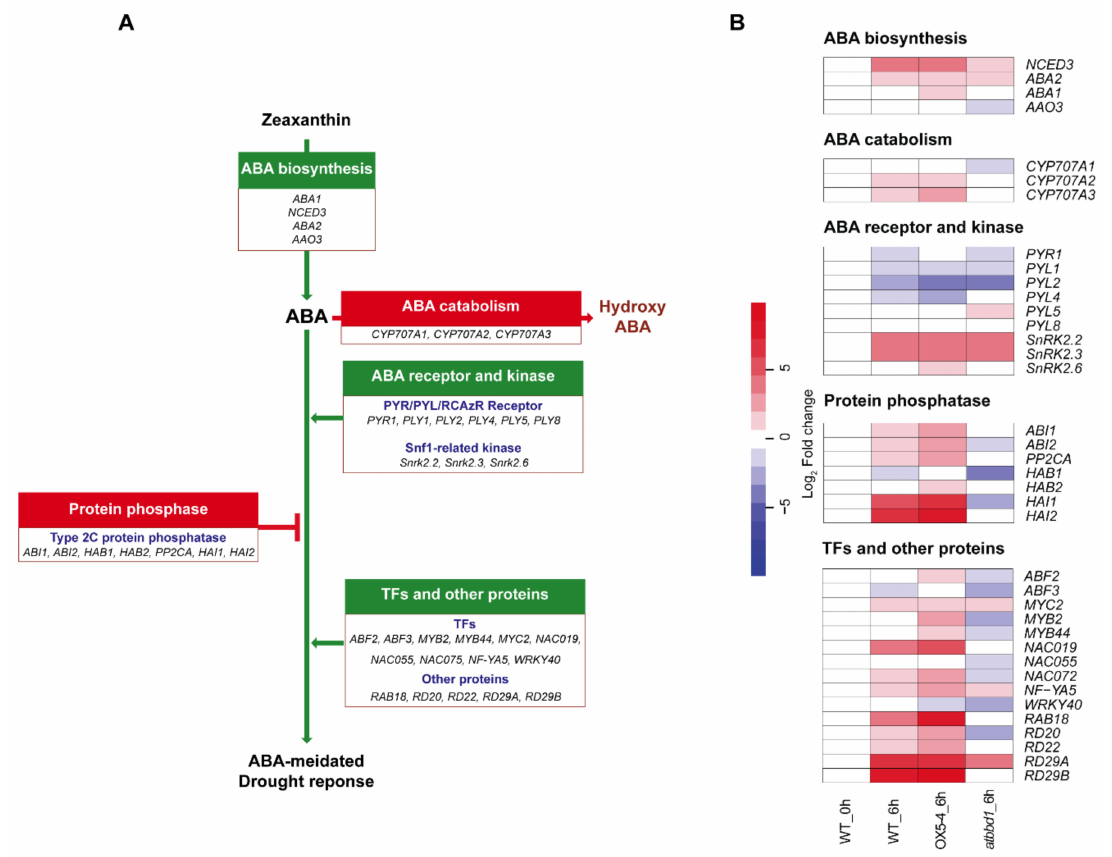
Figure 6. Expression of genes related to ABA and drought stress signaling cascades. ( A ) ABA-dependent signaling network of 38 key genes involved in drought stress response. Genes in the green boxes are positive regulators, while genes in the red boxes are negative regulators of ABA signaling. ( B ) Heatmap showing the expression fold change of 38 key genes involved in the ABA-dependent drought stress signaling network in Arabidopsis thaliana as determined by RNA-seq in the WT, OX5-4, and atbbd1 plants under drought stress conditions. The relative fold change was calculated and normalized with the RPKM value of WT plants without drought treatment. The RPKM value of WT at 0 h was set to